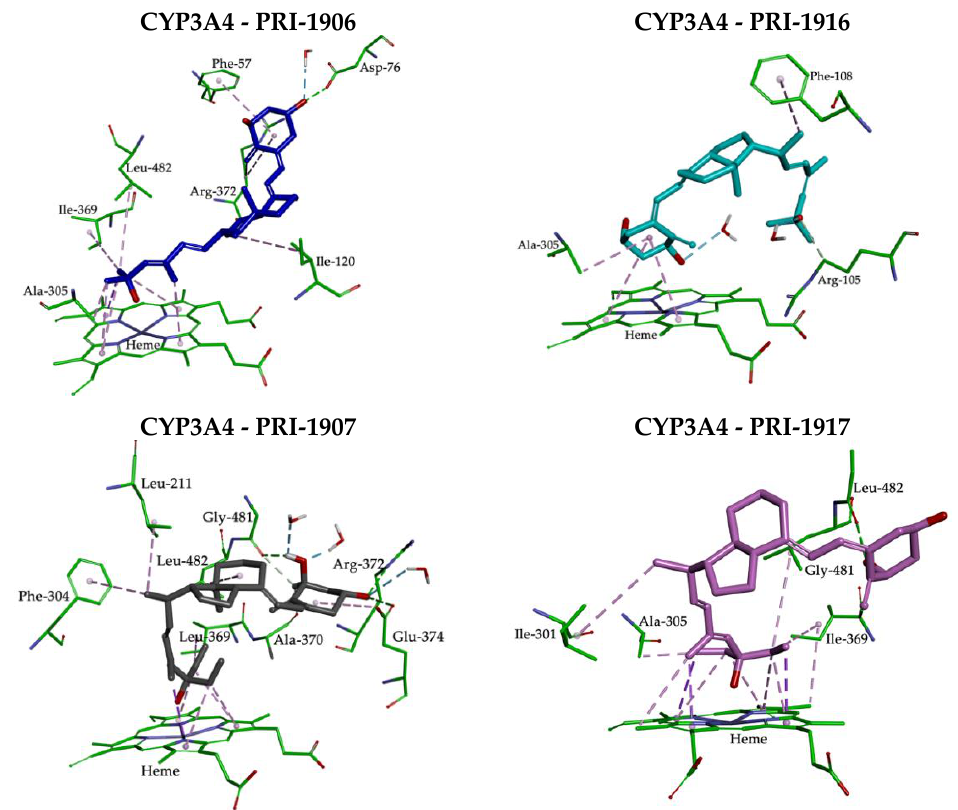
Figure 5. Molecular interactions between 1,25D2 analogs (PRI-1906, PRI-1907, PRI-1916, and PRI-1917) and CYP3A4 resulting from MD simulations. Hydrophobic interactions are shown as magenta dashed lines and hydrogen bonds as green.